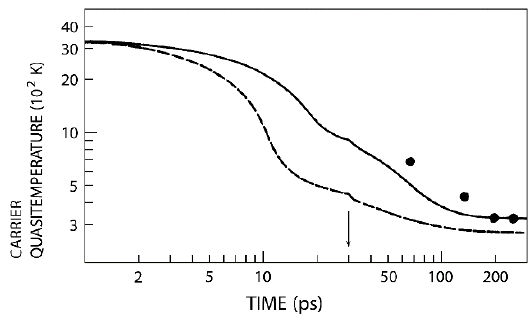
Figure 11. Evolution of the carrier quasitemperature in highly excited GaAs. The NESEF-based calculation (full line) is from Algarte et al. 82 and experimental data (dots) are from Amand & Collet 79 .